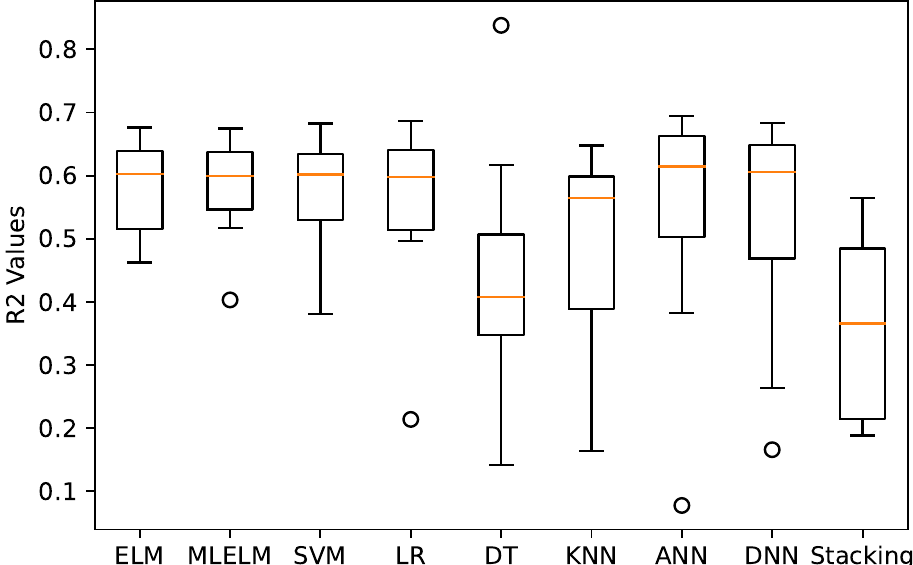
Figure 10. The performance of various models for annual building energy consumption: R 2